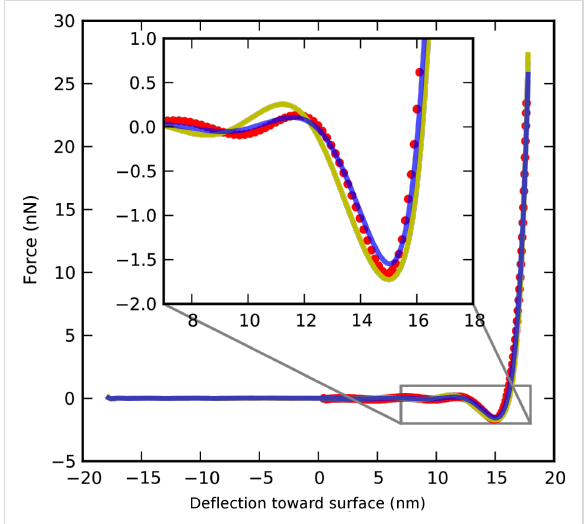
Figure 5: Comparison of force reconstructions for a tip interacting with silicon oxide. Polynomial reconstruction from spectral data (yellow), force quadrature data (blue) and ADFS reconstruction (red circles) are in good